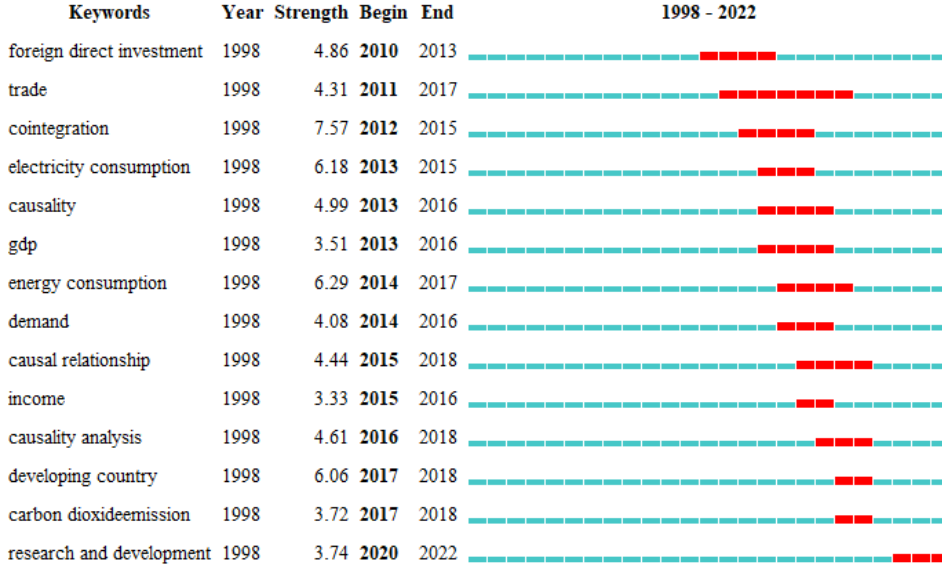
Figure 9. A landscape view of the co-citation network (by CiteSpace).